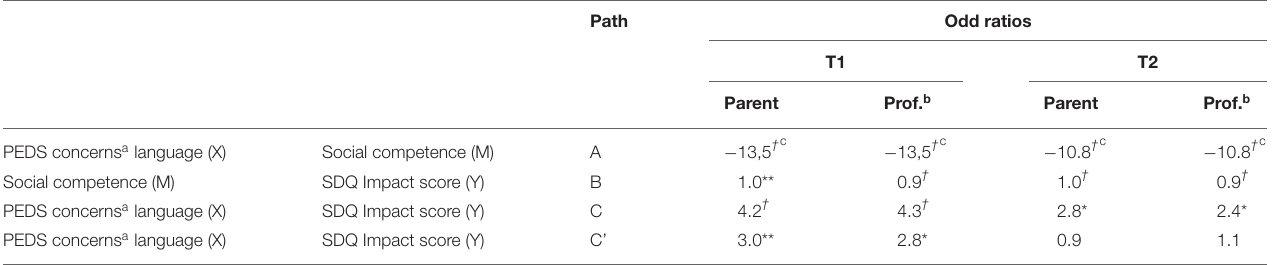
TABLE 7 | Mediating effect of social competence on the association of PEDS concerns about language development with SDQ impact score at T1 and T2.